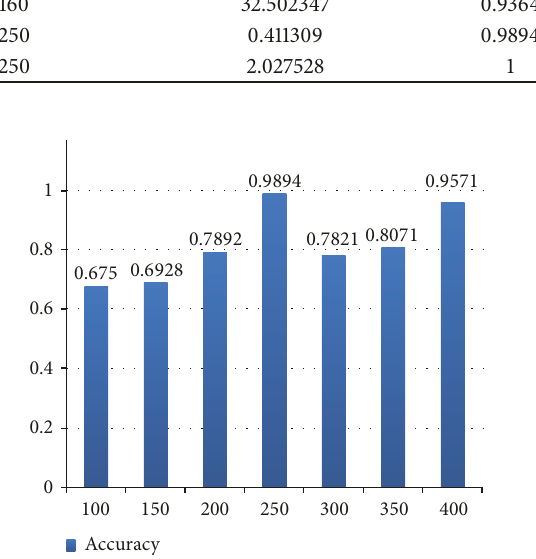
Figure 7: The results with different numbers of hidden neurons in